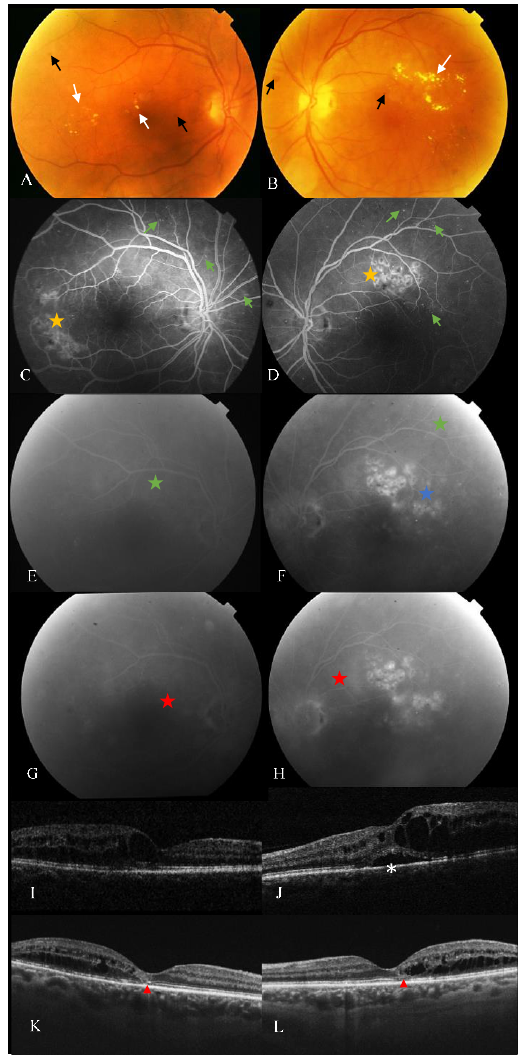
Figure 1. Retinal alterations despite sustained intravitreal therapy for DMO. Color fundus photography ( a , b ), fluorescein angiography (FA) ( c , h ), and spectral-domain optical coherence tomography (SD-OCT) ( i , l ) of a patient with nonproliferative diabetic retinopathy and refractory diabetic macular oedema (rDMO). ( a , b ) Hard exudates (top left and right, white arrows), microaneurysms and retinal hemorrhages (black arrows). ( c , d ) Early phase of FA showing multiple hyperfluorescent spots predominantly from areas with microaneurysmatic changes (green arrows) and hyperreflectivity of focal laser scars (yellow stars). ( e , h ) Late-phase of FA of the same patient showing diffuse leakage from microaneurysm (green stars), circinate areas (blue stars) towards and within the foveal avascular zone corresponding to rDMO (red stars). ( i , j ) SD-OCT displaying multiple intraretinal cysts and subfoveal neuroretinal detachment (white asterisk). ( k , l ) B-scans of the same patient, 14 years after multiple treatments, showing refractory cystoid macular oedema, multiple hyperreflective dots and disruption of external retinal layers (red arrowheads).